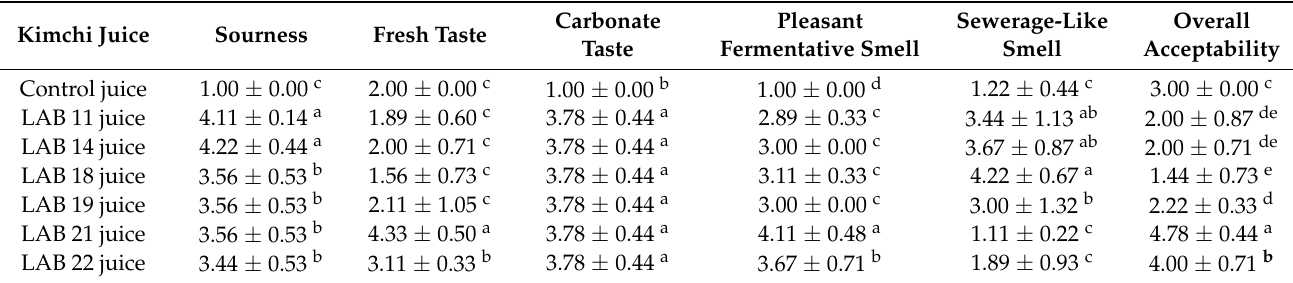
Table 2. Sensory evaluation of kimchi juice fermented using the LAB